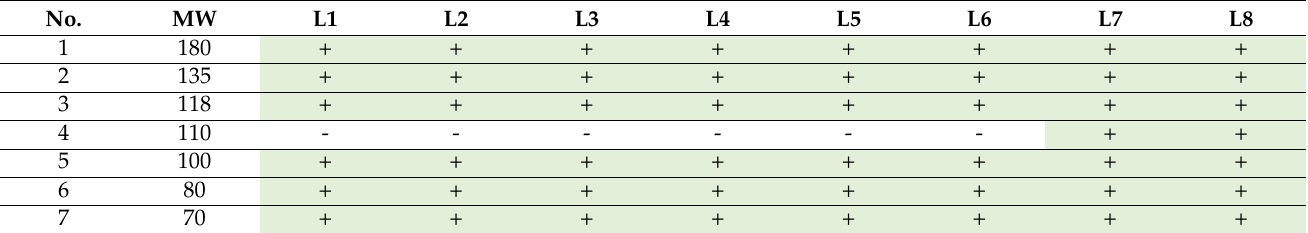
Table 3. Change in protein pattern in putrescine-pretreated wheat plants under water deficit